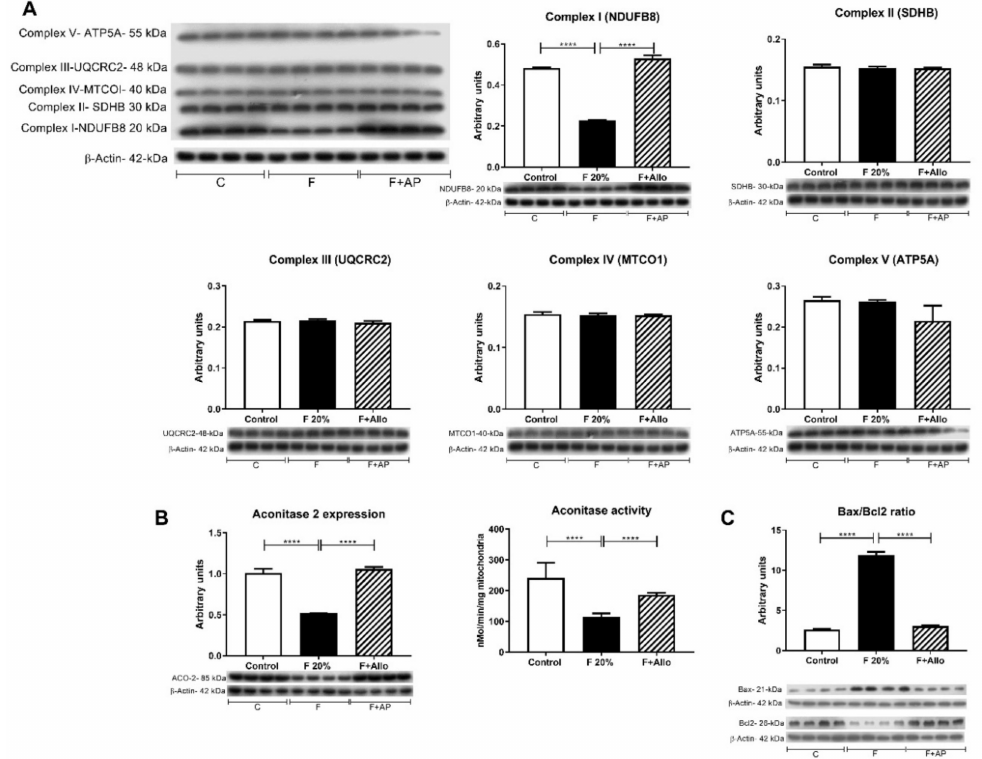
Figure 2. Mitochondrial complexes expression by western blot, aconitase 2 expression and activity and Bax / Bcl2 ratio. ( A ) Short term high fructose feeding only decreased the expressions of mitochondrial respiration Complex 1 and ( B ) aconitase 2. Fructose also decreased aconitase 2 activity ( B ). On the contrary, Bax / Bcl2 ratio was increased by high fructose feeding ( C ). Allopurinol treatment prevented all these e ff ects. For western blotting, 4 out 5 randomly selected samples per group were analyzed. **** = p <